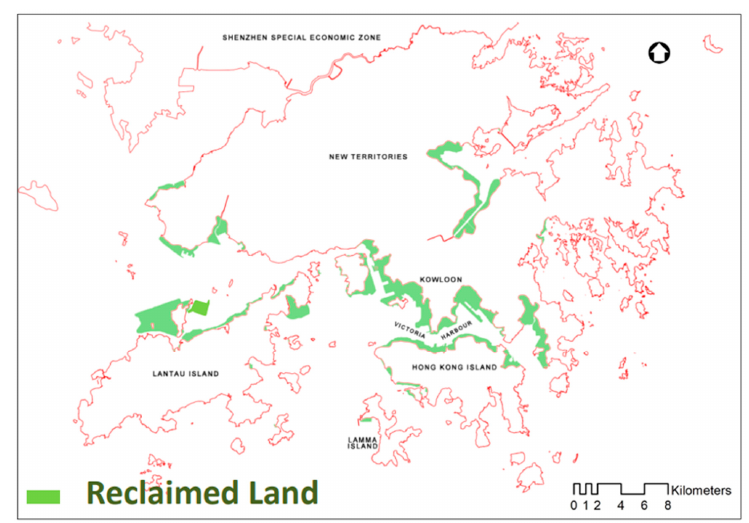
Figure A6. Reclamation land in Hong Kong [45].